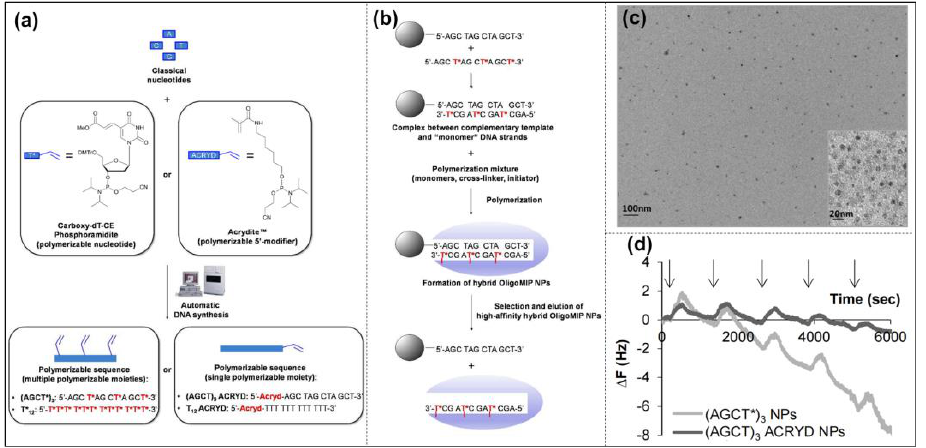
Figure 3. MIP − NPs were prepared using a solid-phase blot polymerization strategy using oligomer DNA sequences as template molecules. Schematic for the preparation of polymerizable oligonucle- otide sequences used as recognition elements in the MIP − NPs composition ( a ); schematic represen- tation of the solid-phase synthesis and selection of oligo MIP − NPs ( b ); TEM image of MIP − NPs ( c ); QCM graph of (AGCT)3 acrylic MIP-NPs and (AGCT*)3 MIP − NPs ( d ). Reprinted with permission from Ref. [59]. Copyright 2016, Royal soc of chemistry.